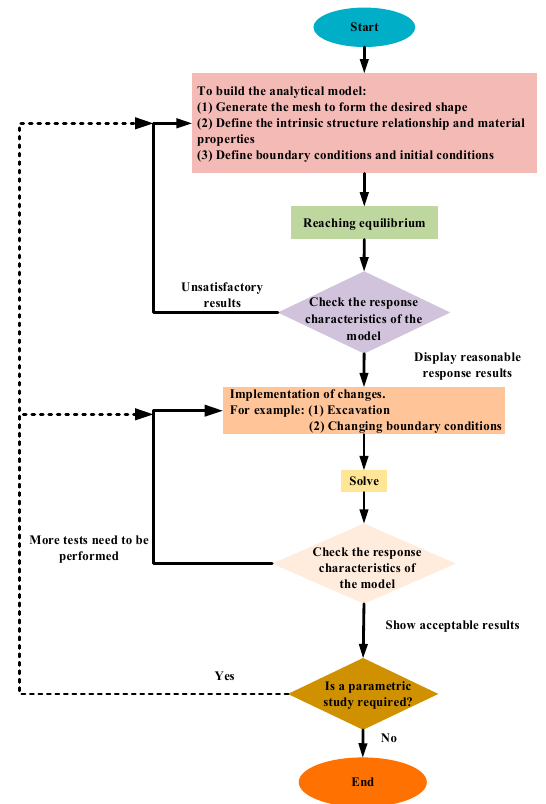
Figure 8. Flowchart of the simulated solution